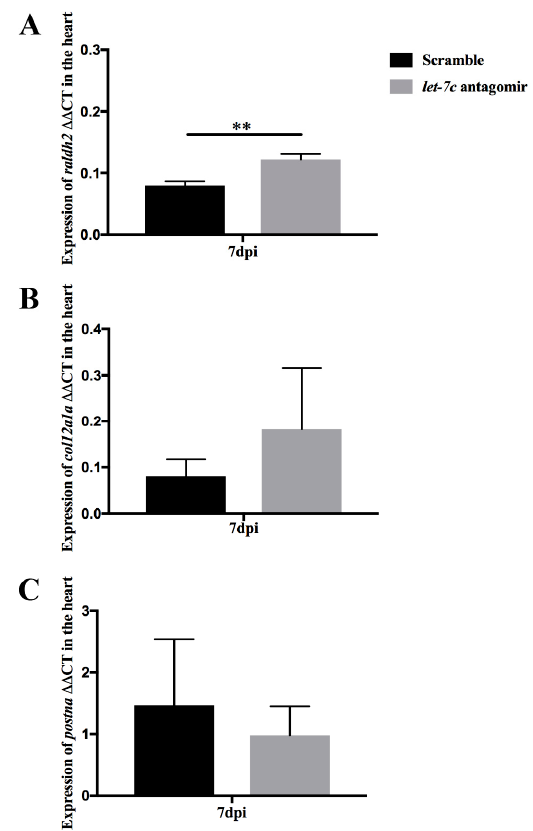
Figure 5. Marker genes of activated epicardial cells (( A ); raldh2 ) and fibroblasts (( B ) col12a1a , ( C ); postna ) quantified with qPCR from hearts at 7 dpi. The internal control gene rps3 used for normalizing the expression levels by the ΔΔ CT method. ( n = 6 in all groups). ** p ≤ 0.005.